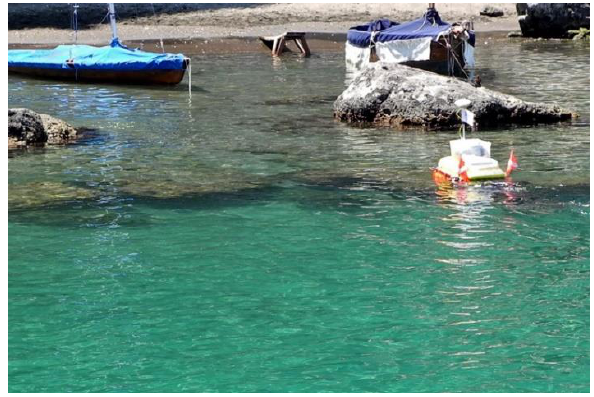
Figure 8. MicroVega in navigation